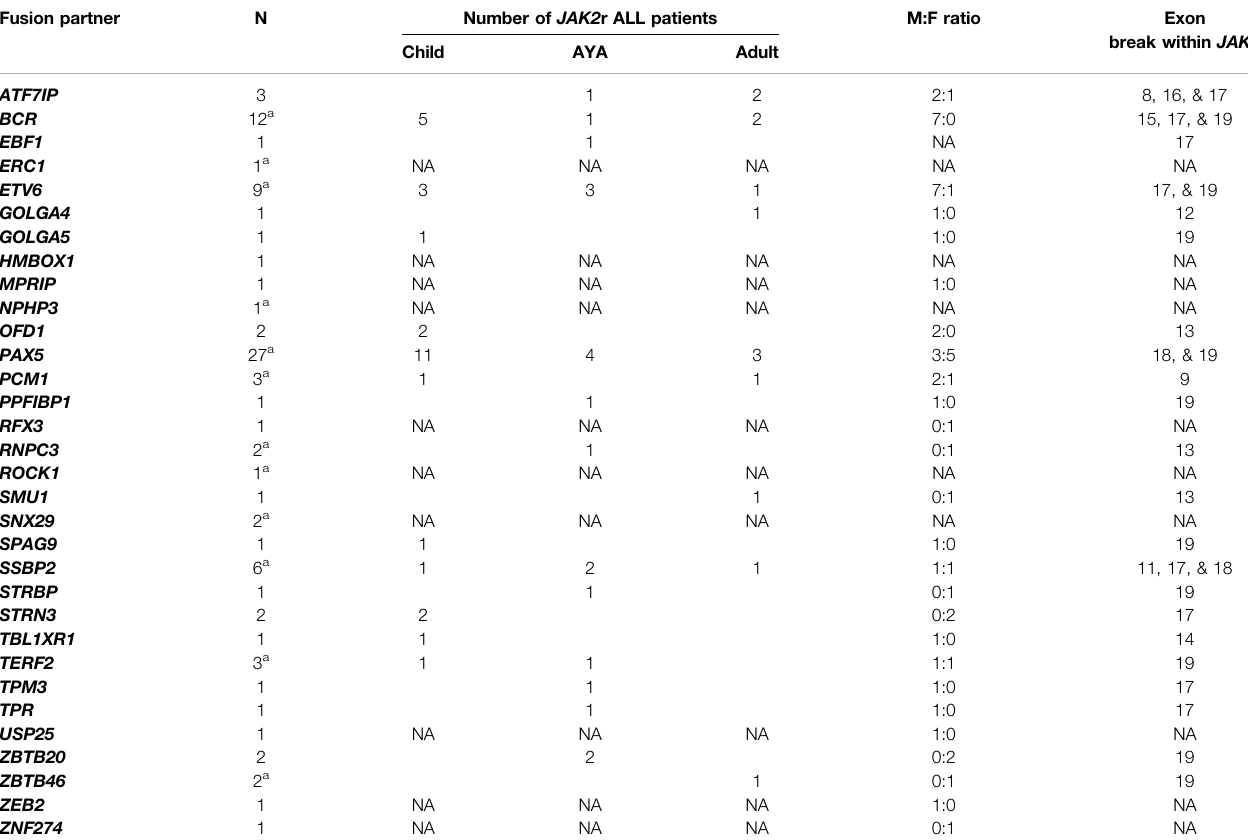
TABLE 3 | Reported JAK2 fusion gene partners in patients with JAK2 r ALL. For more details and corresponding references see Supplementary Table S1 . The JAK2 pseudokinase domain is encoded by JAK2 exons 13-18. Fusion